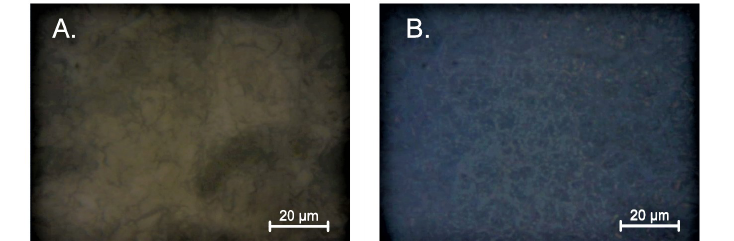
Figure 4. Summary of the morphology for the layers produced on quartz ( A ) using a solution with 5% concentration of DEA; ( B ) using a solution with 5% concentration of